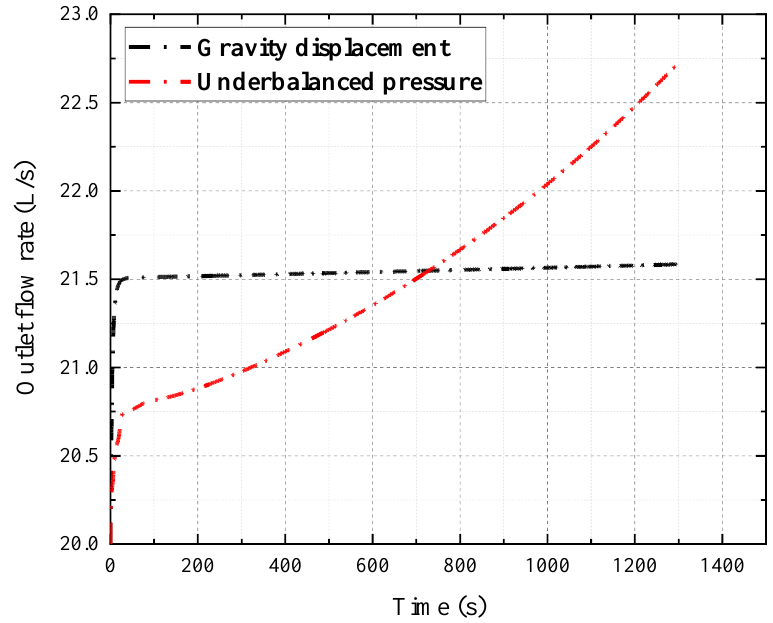
Figure 7. Comparison of the outlet flow rate for well M.